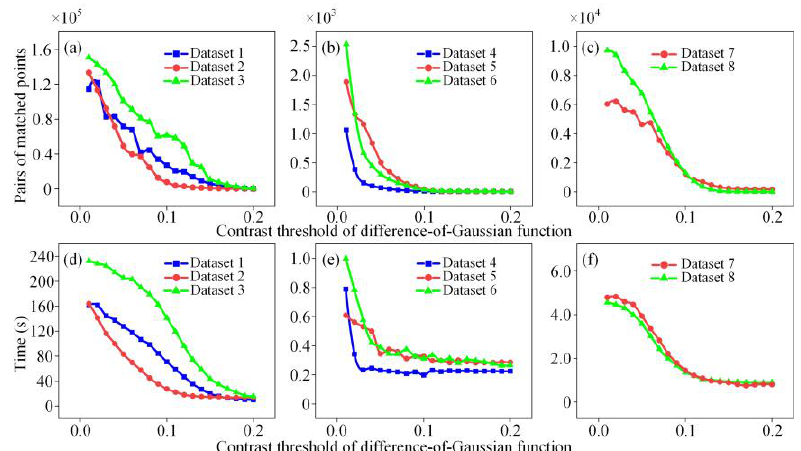
Figure 4. Number of matched feature points and matching time for the crop growth UAV images under different contrast thresholds in DOG scale-space. ( a ), ( b ), and ( c ) show the numbers of matched feature points for visible, thermal infrared, and near-infrared images, respectively. ( d ), ( e ), and ( f ) show the times for the matching of feature points for visible, thermal infrared, and near-infrared images, respectively.